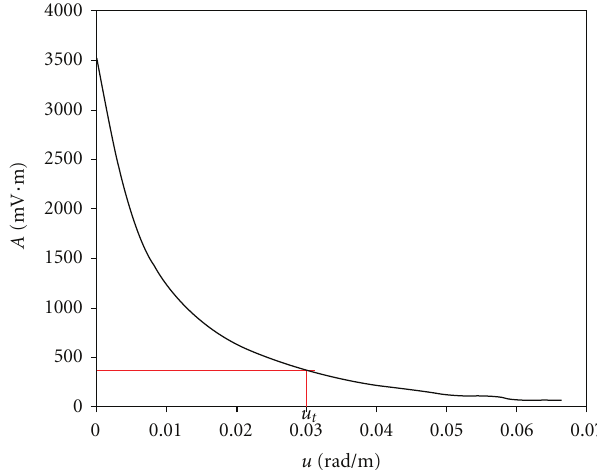
Figure 6: The amplitude spectrum of the SP curve of the synthetic model.